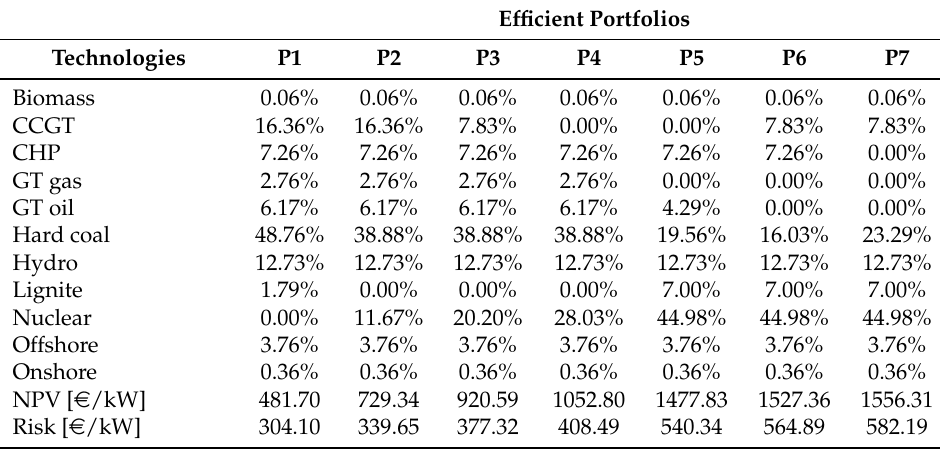
Table A8. Efficient portfolios according to the MV Model for existing technologies combined with new investments.